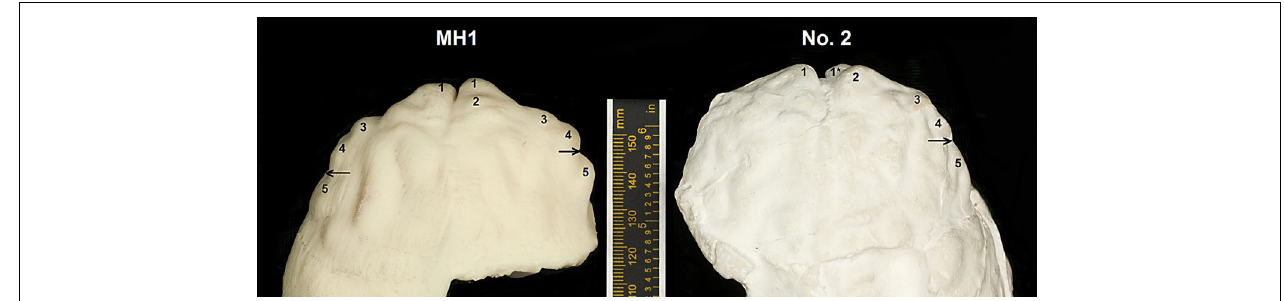
FIGURE 7 | Dorsal view of frontal lobes of MH1 ( Australopithecus sediba ) and the No. 2 endocast from Sterkfontein ( Australopithecus africanus ). Numbers indicate comparable shape features: 1, frontal poles; 1 ∗ , fragment of frontal pole; 2, swelling above the right frontal pole near the superior sagittal sinus; 3,4, double bumps on perimeter of frontal lobe that are relatively lateral to the frontal poles, giving the rostral ends